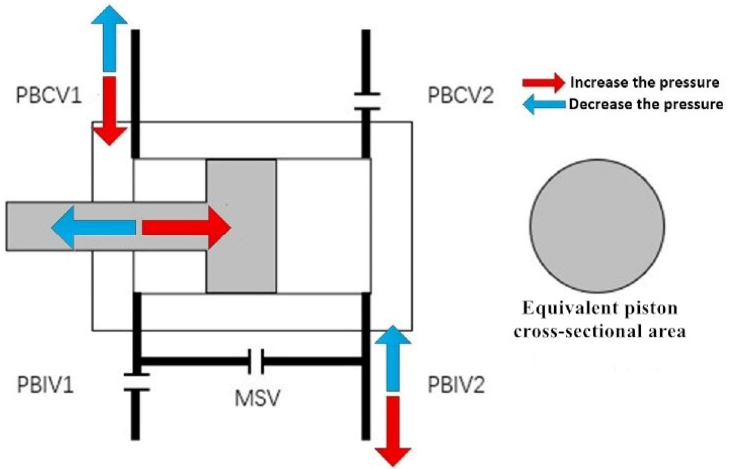
Figure 3. The flow direction of brake fluid and the action of solenoid valves under low pressure mode.